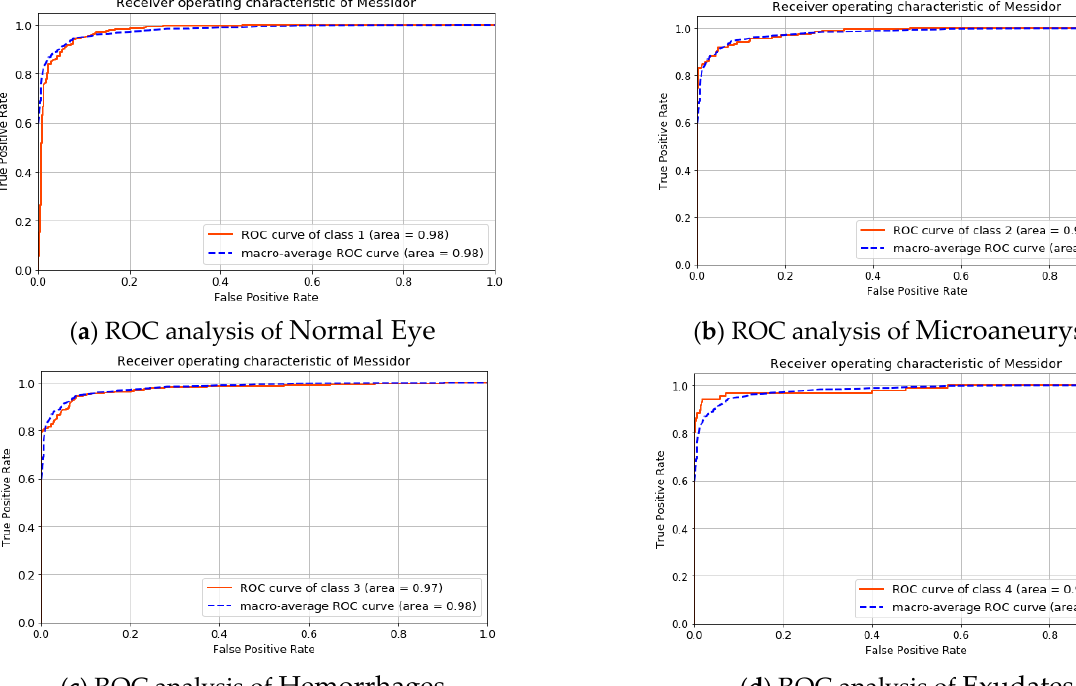
Figure 8. ROC analysis for the MESSIDOR dataset.